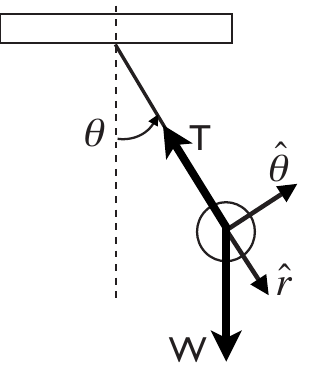
FIG. 2. The forces on a simple pendulum, with a physicist’s polar coordinate